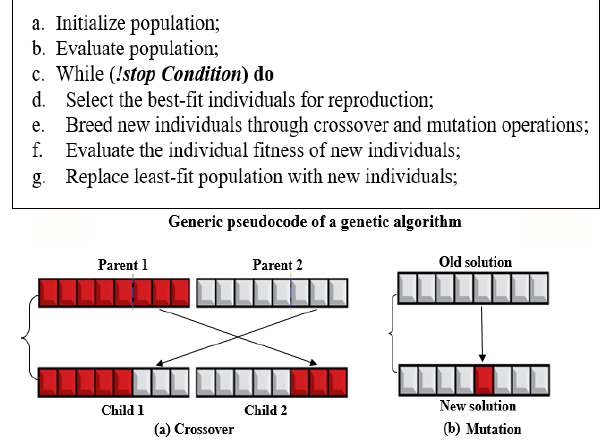
Figure 16. Steps to introduce diversity in a population: (a) crossover; (b)